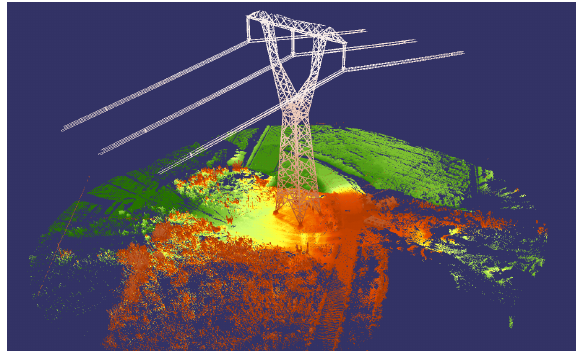
Figure 13. Diagram of Point Cloud Scanned by Laser 3D Scanner at K182.